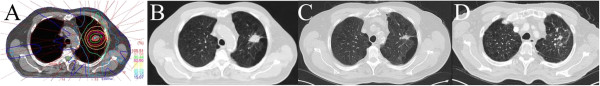
Radiotherapy plan (A), pre-radiotherapy CT (B), follow-up CTs 2 months post-RT (C) and 1 year post-RT (D) of a typical patient. Complete regression of the irradiated lesion can be observed without marked changes in healthy lung structure.